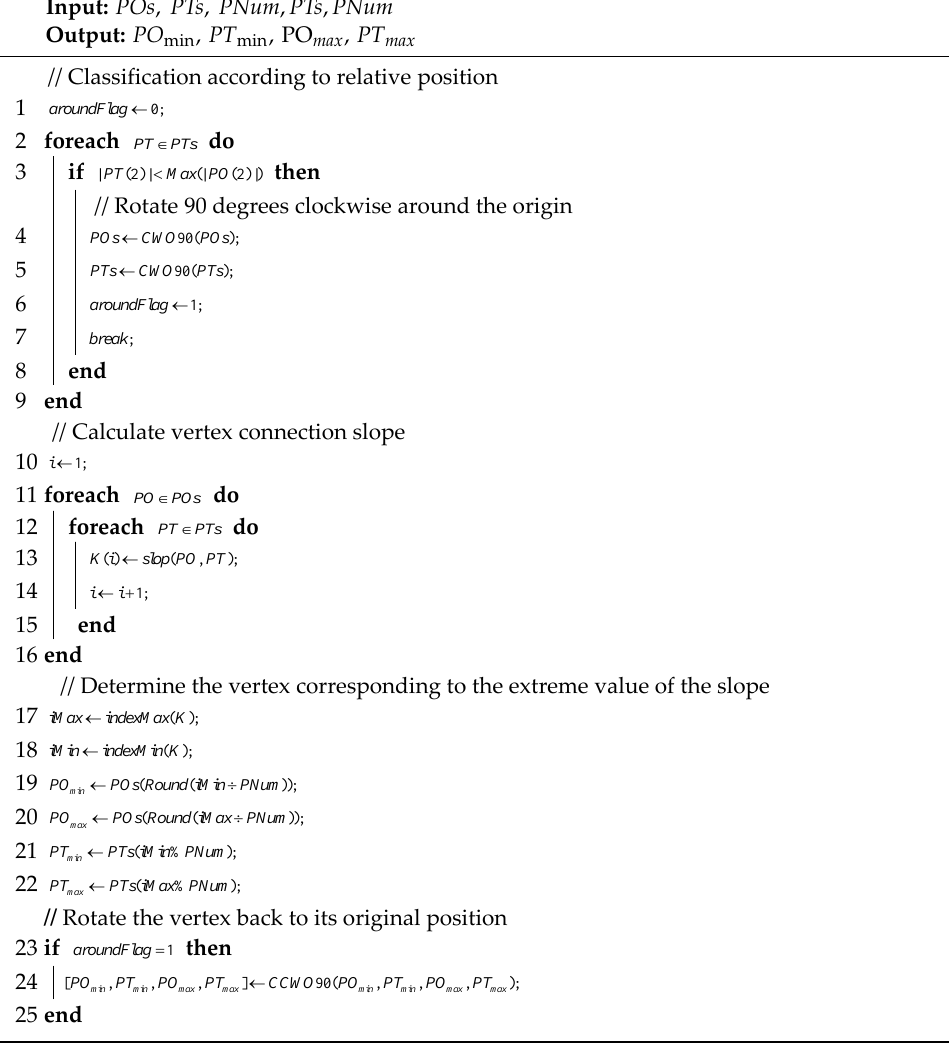
Algorithm 1: Select critical collision point by slope